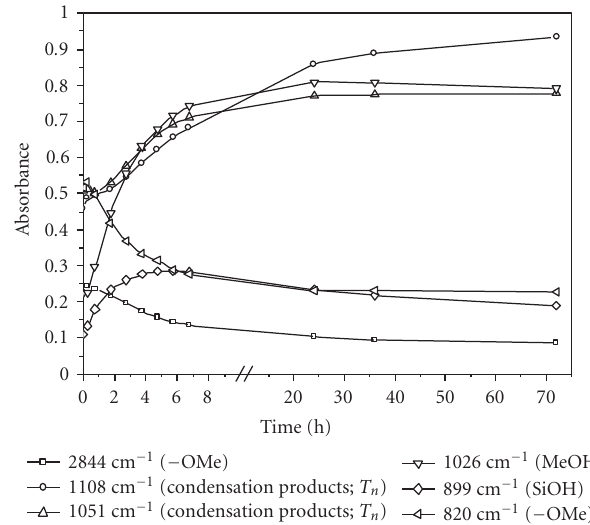
Figure 2: Intensity changes of the selected bands versus time of age-